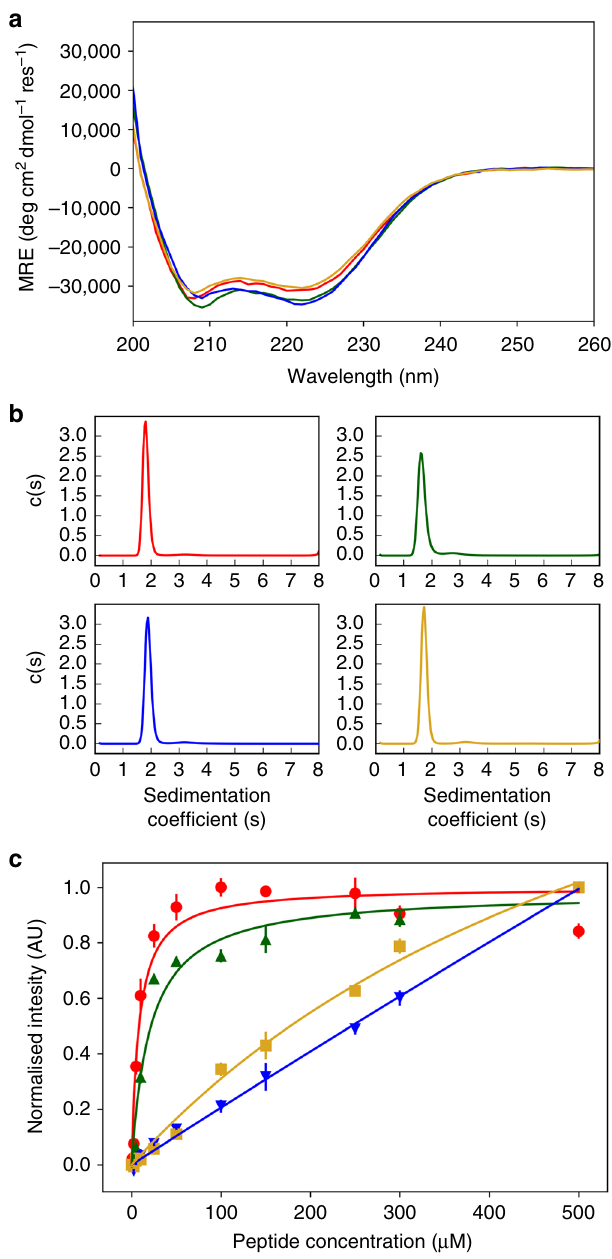
Fig. 2 Solution-phase biophysics of representatives of the classes of CC- Type2 sequences. a CD spectra (averages of n = 8). b Sedimentation velocity c(s) distribution fi ts with 95% con fi dence limits. c Binding of DPH followed by fl uorescence emission at 455 nm. Error bars represent mean ± standard deviation from n ≥ 3 independent measurements. Key : ββ (CC- Type2-IV), red lines and circles; L β (CC-Type2-LI) green lines and upward- pointing triangles; β L (CC-Type2-IL-Sg) blue lines and downward-pointing triangles; and LL (CC-Type2-LL), yellow lines and squares. Conditions: ( a ) 10 μ M peptide, 20 °C; ( b ) 150 μ M peptide, 20 °C; ( c ) 1 μ M DPH, 5% v/v DMSO, 25 °C. Phosphate-buffered saline (PBS) solution, pH 7.4. Data for CC-Type2-LI in panels ( a ) and b are from ref.